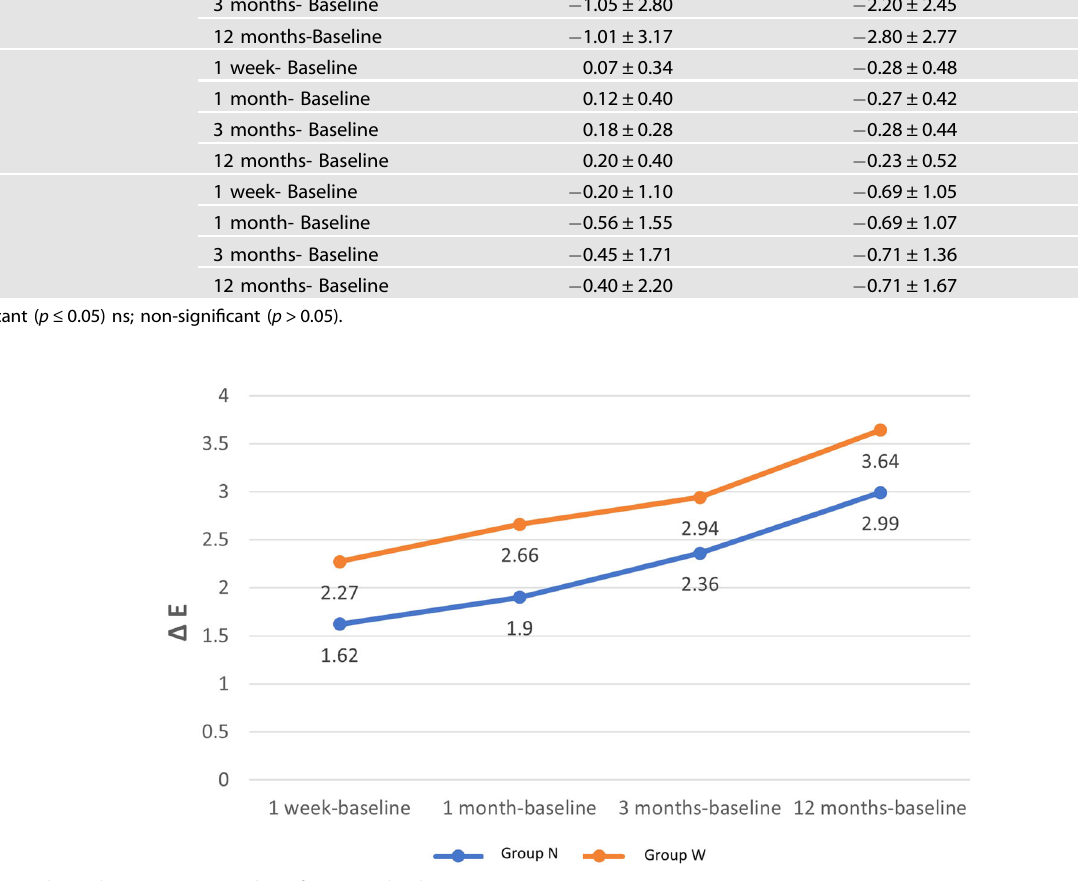
Fig. 4 Line chart showing mean values for Δ E in both